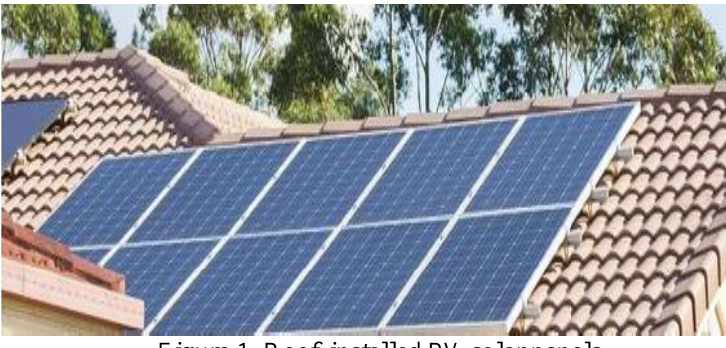
Figure 1. Roof-installed PV solar panels